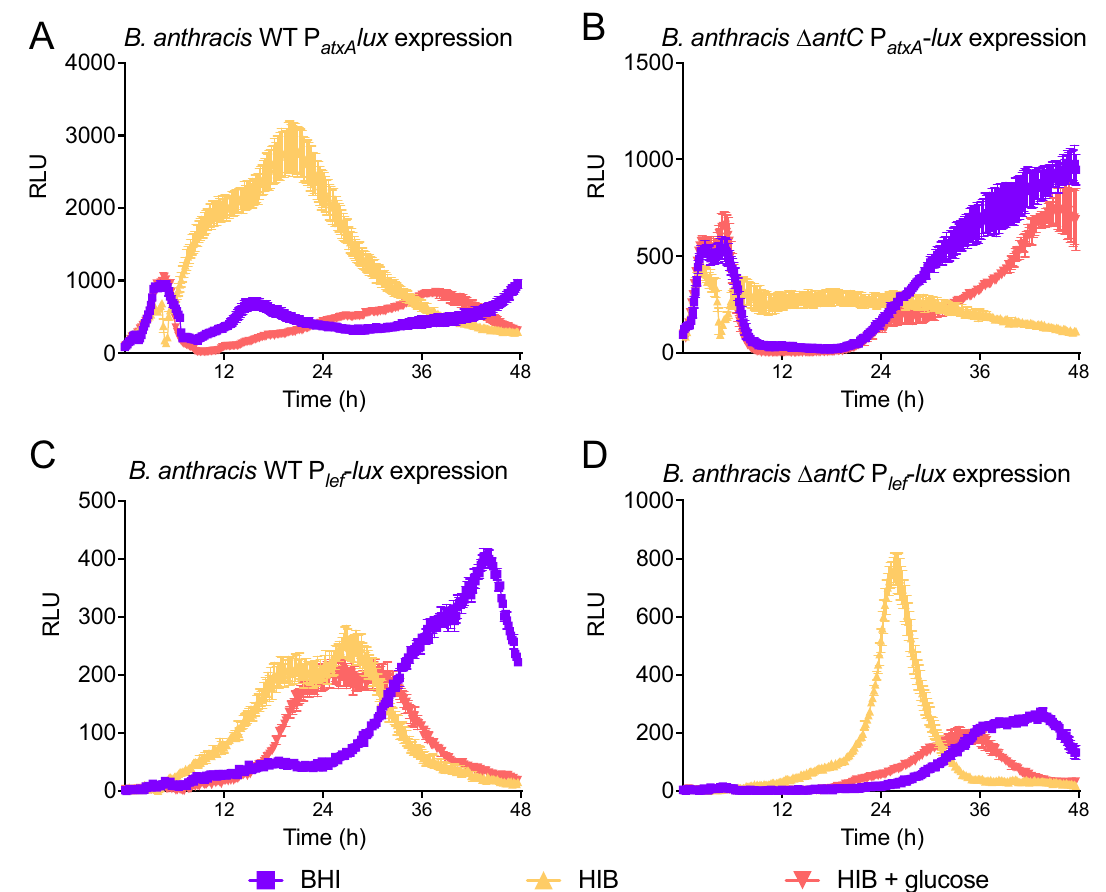
Figure 6. Luminescent expression patterns of B. anthracis virulence related promoters are affected by nutrient components. Luminescent expression patterns of ( A ) Sterne WT P atxA - lux ( B ) Sterne Δ antC P atxA - lux ( C ) Sterne WT P lef - lux and ( D ) Sterne Δ antC P lef - lux , (grown in BHI + Km 10 (purple lines), HIB + Km10 (orange lines), or HIB + Km10 + 2 mg/ml glucose (red lines) show anthrose status has different effects on expression in high protein versus high sugar nutrient